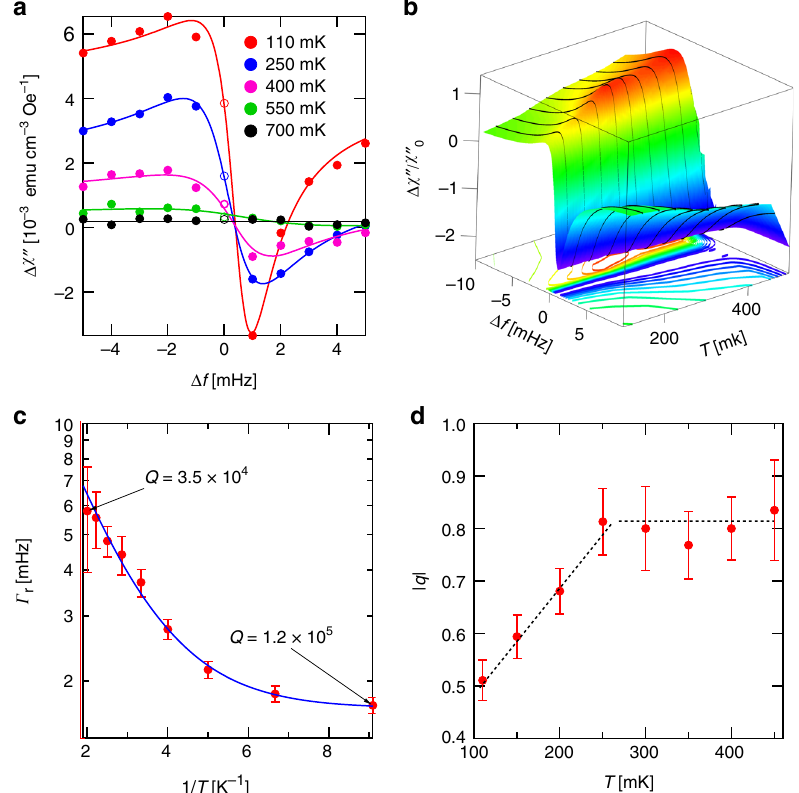
Fig. 2 Linear absorption spectra of LiHo 0.045 Y 0.955 F 4 as a function of temperature. a Measured absorption in the presence of a 0.3 Oe pump fi eld at f pump = 202 Hz and zero transverse fi eld; probe fi eld has 20 mOe amplitude. Curves are fi ts to Fano resonance forms, Eq. (2) in the text. The points at f = f pump (open symbols) are omitted from the fi ts (see text for details). b Absorption normalized with respect to the response at Δ f = 30 mHz as a function of frequency and temperature. Color and z position both indicate normalized absorption. c Linewidth of the resonance, as determined from fi tting to the Fano model, vs. temperature T . Line is a fi t to an intrinsic linewidth of 1.7 mHz plus exponential thermal broadening with Δ = 740 mK . d Fano parameter q vs. temperature, showing the suppression of coupling to the bath at the lowest T . Lines are guides to the eye. All error bars are